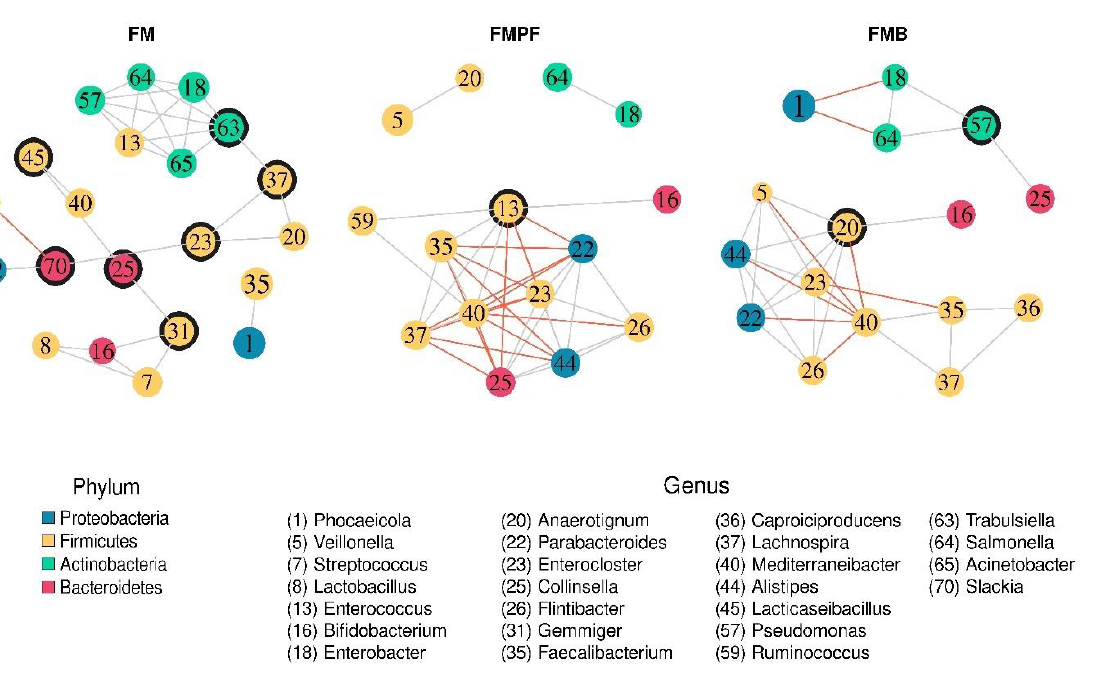
Figure 6. Co-occurrence networks of the genera identified by type of fermented milk treatment. Pearson’s correlation coefficients (r = ± 0.75) were used at 95% confidence ( p < 0.05). Positive and negative relationships are represented by links in gray and red, respectively. The filling color of the nodes represents the phylum to which the genus belongs. Articulation points (nodes whose absence would break the continuity of the modules) are highlighted with an external line.